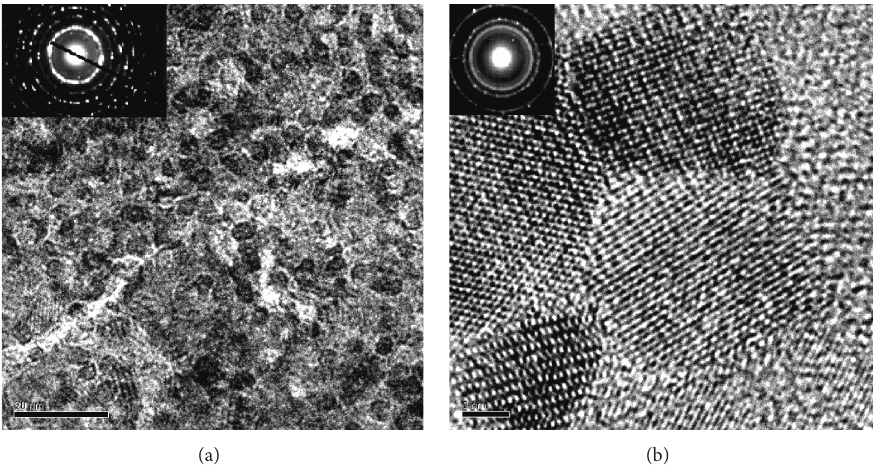
Figure 2: TEM images and selected area electron diffraction patterns of NSSL at different levels of magnification: (a) 200 K and (b) 1.2M.